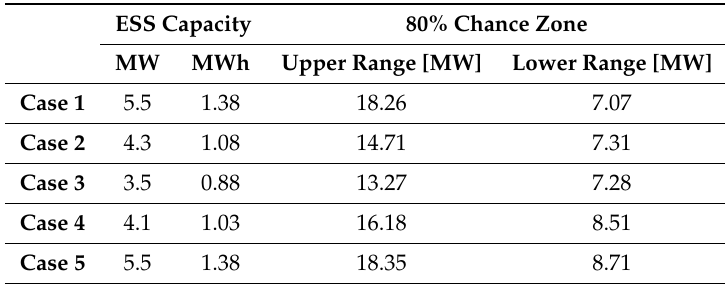
Table 2. ESS capacity and operation parameters for dispatchable substation for each case in Table